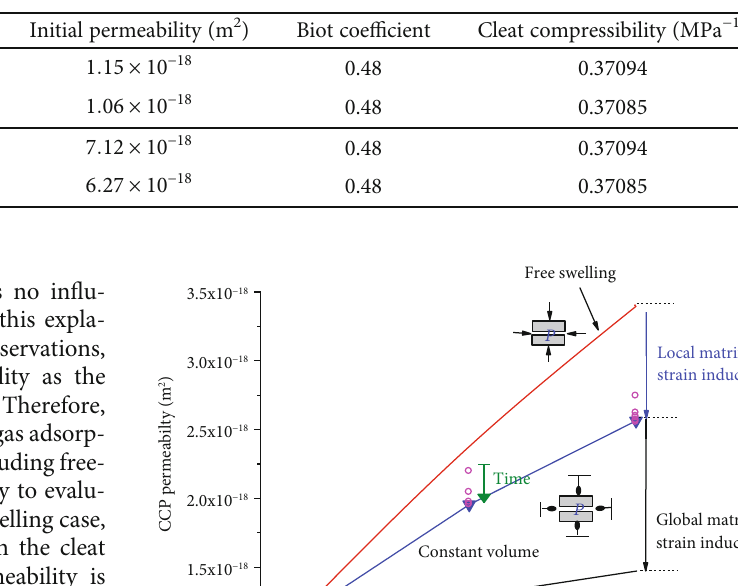
Table 3: Parameters used in permeability curve fi tting.